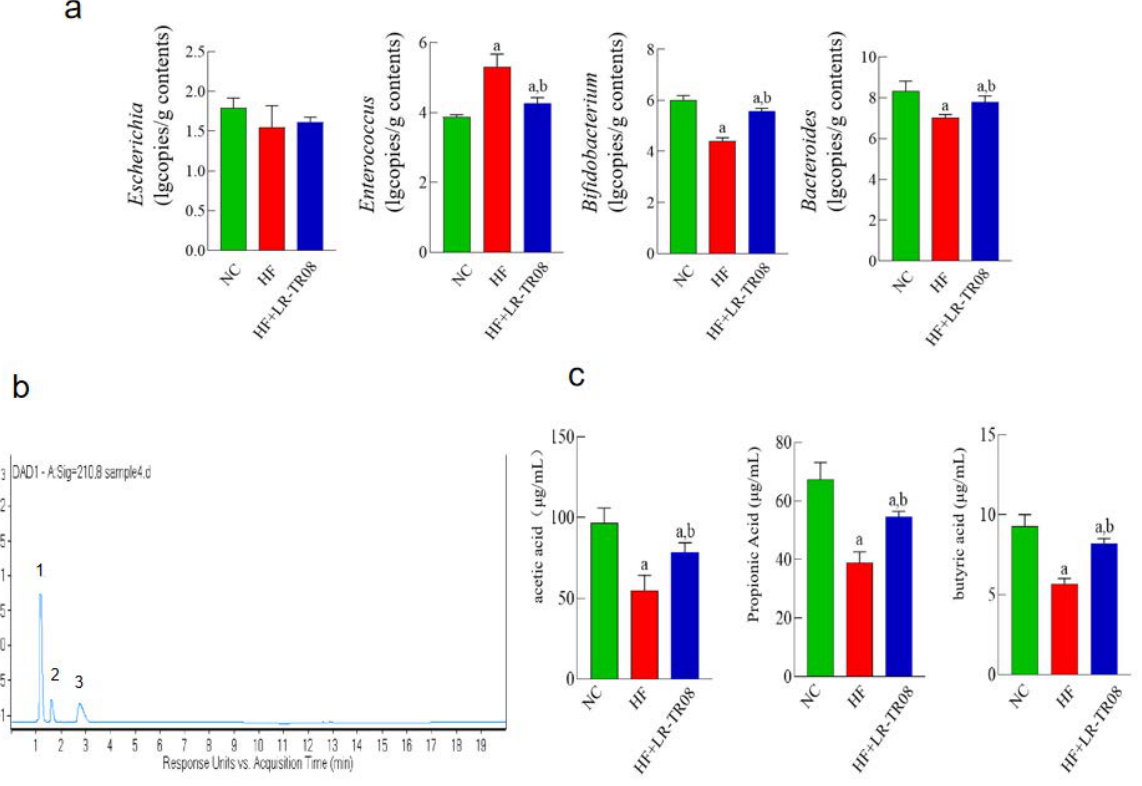
Figure 3. Changes of relative contents of four important bacterial groups (Bifidobacterium, Bac- teroides, Escherichia , Enterococcus ) in colon contents of mice and the plasma concentrations of acetic acid, propionic acid and butyric acid. Normal control group: NC, high-fat diet group: HF, and high-fat diet + L. rhamnosus TR08 strain group: HF+LR–TR08. ( a ): the relative contents of four important bacteria in colon contents of mice were detected by qPCR ( b ): the ion flow diagram of acetic acid, propionic acid, and butyrate in mouse plasma by LC–MS/MS. ( c ): plasma concentrations of acetic acid, propionic acid, and butyric acid in each group a: compared with the NC group, p < 0.05; b: compared with the HF group, p <